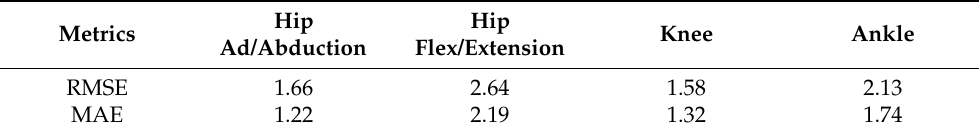
Table 3. Metrics between desired trajectory and the unadjusted trajectory.